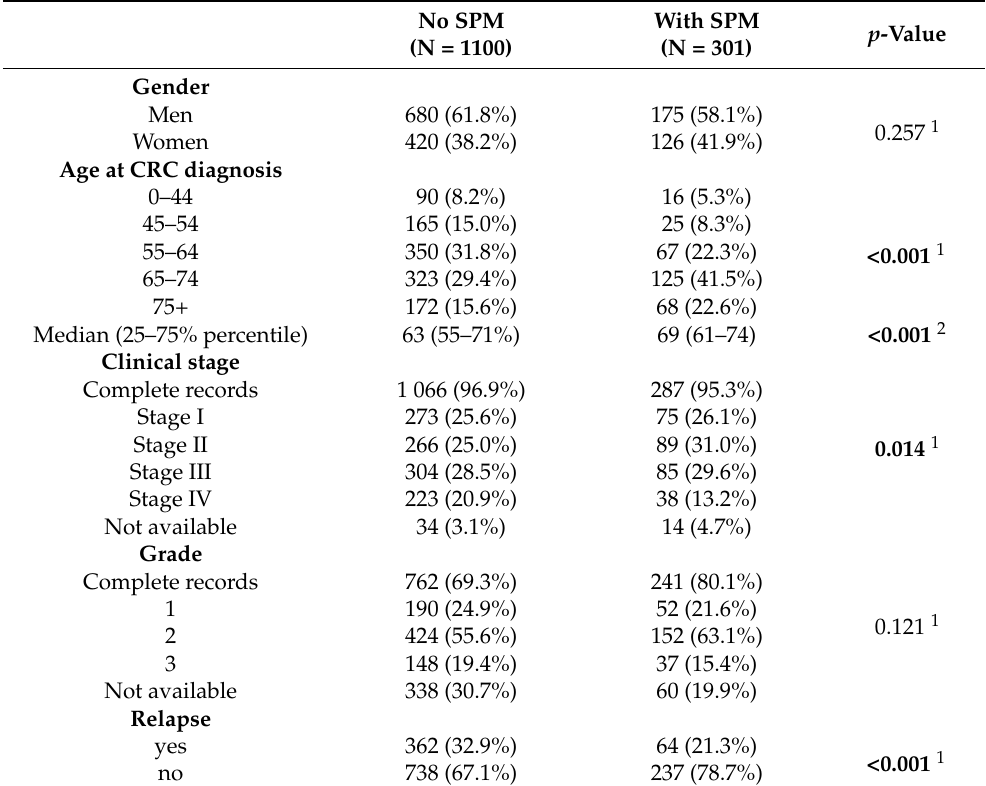
Table 1. Characteristics of colorectal cancer patients (C18–C20), stratified by the occurrence of a second primary